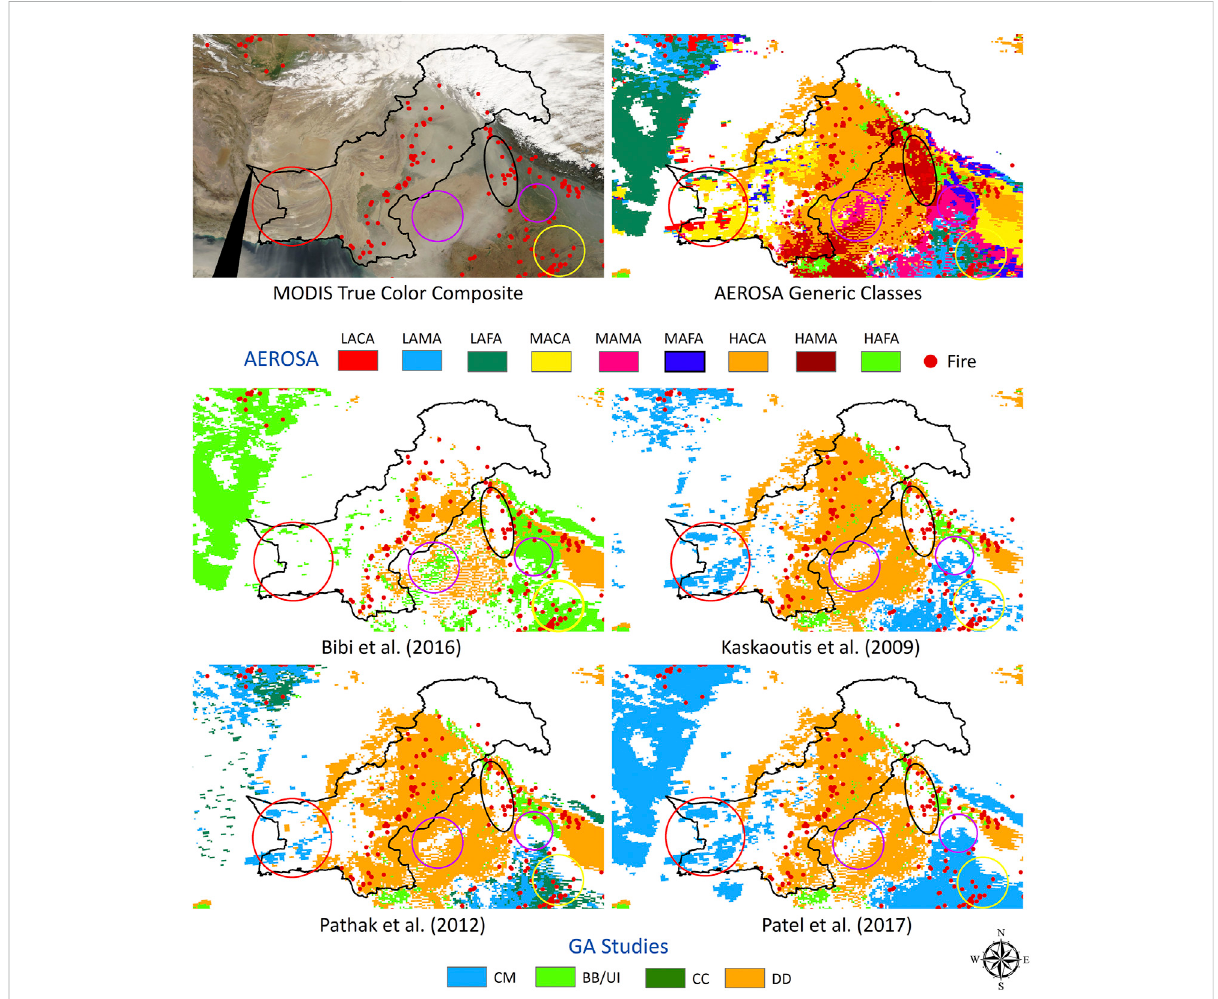
FIGURE 3 A severe dust storm over Pakistan and neighboring countries on 20th Match 2012. (A) True color composite using MODIS data, showing the occurrenceofdustand fi res(reddots);thewhiteareasindicateclouds; (B) AEROSAgenericclasses. (C – F) Aerosoltypeswereclassi fi edusingtheGA methods published by Bibi et al. (2016) (C) ; Kaskaoutis et al. (2009) (D) ; Pathak et al. (2012) (E) ; Patel et al. (2017b) (F) . Where LACA: low-amount coarse-mode aerosols, LAMA: low-amount mixed-mode aerosols, LAFA: low-amount fi ne-mode aerosols; MACA: medium-amount coarse- mode aerosols, MAMA: medium-amount mixed-mode aerosols, MAFA: medium-amount fi ne-mode aerosols; and HACA: high-amount coarse- mode aerosols, HAMA: high-amount mixed-mode aerosols, HAFA: high-amount fi ne-mode aerosols; CM = clean maritime aerosols; CC = clean continental aerosols; BB/UI: biomass burning/urban-industrial aerosols; and DD: desert dust